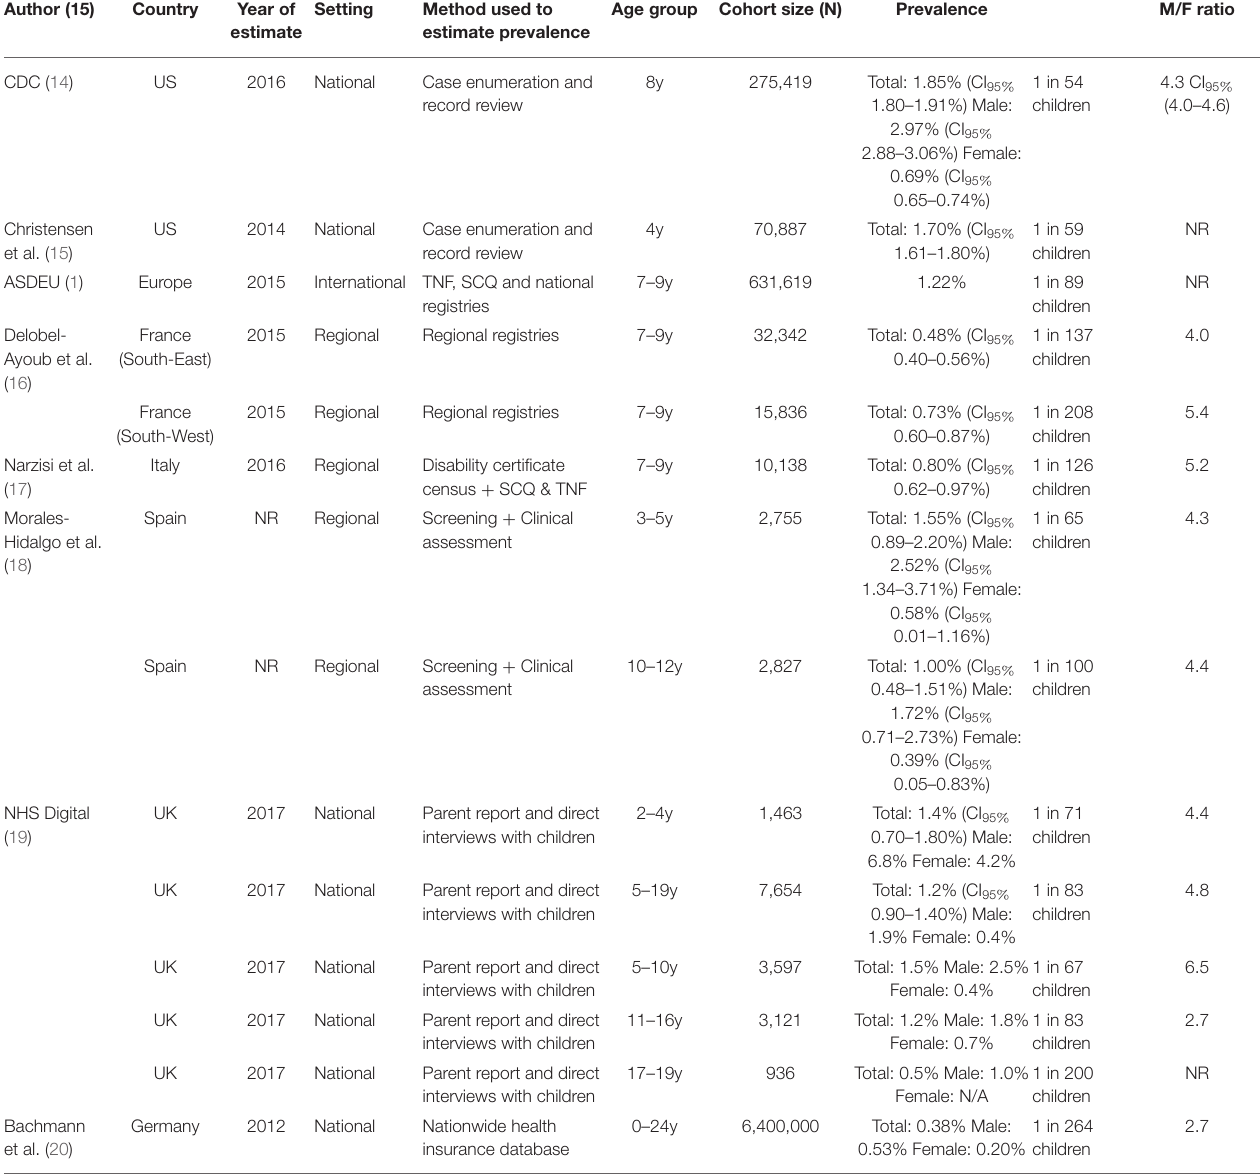
TABLE 2 | Latest data on the prevalence of ASD *